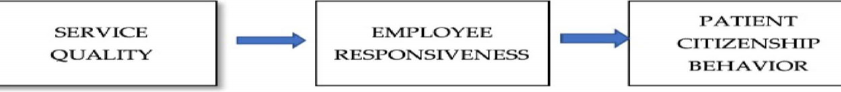
Figure 3. Mediating Effect of Patient Loyalty.